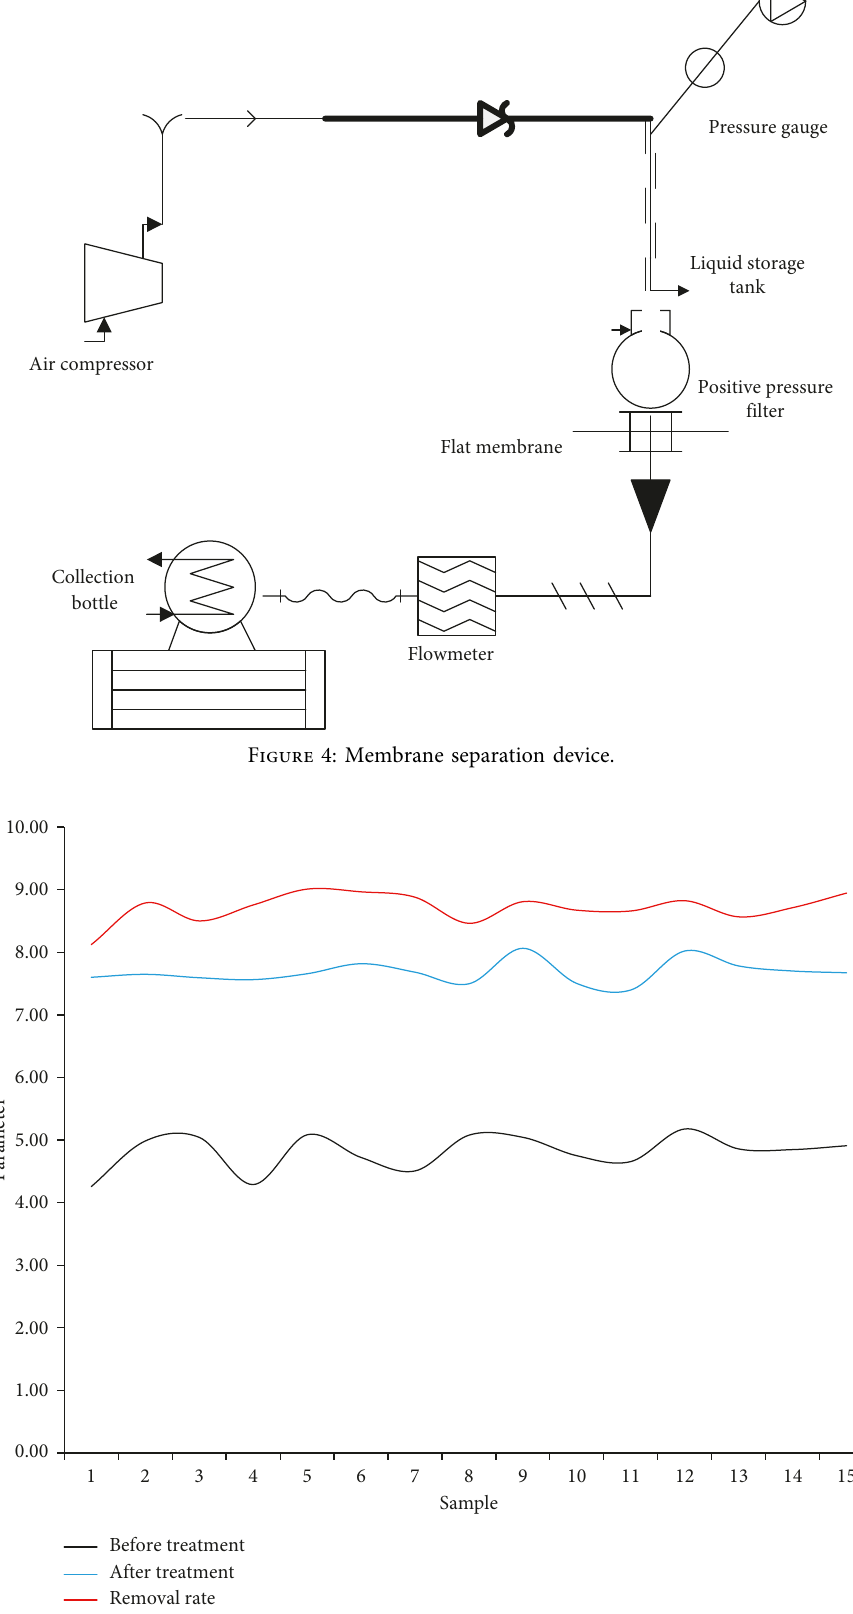
Figure 5: Overall removal